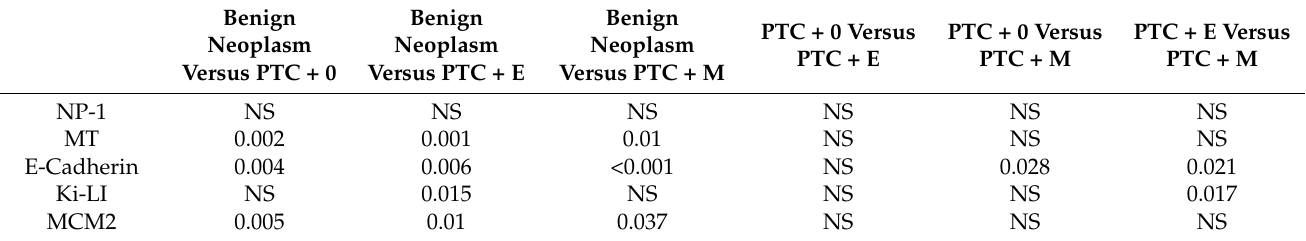
Table 3. Comparisons of immunohistochemical staining intensity score in-between the different studied